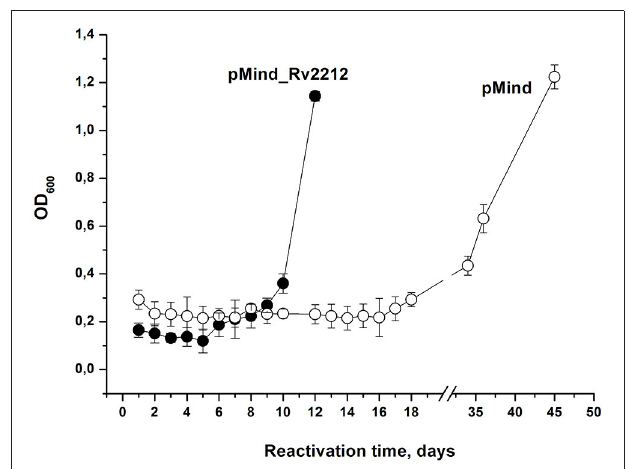
FIGURE 4 | Overexpression of Rv2212 results in faster resuscitation of dormant M. tuberculosis . Non-culturable Mtb pMind Rv2212 (closed circles) or pMind (open circles) obtained from the “glycerol” Sauton’s modified medium after 180-d incubation (see the legend to Figure 2A ) were washed, inoculated in the reactivation medium and incubated with agitation (100 rpm) at 37 ◦ C. For the details see Materials and Methods. The experiment was repeated two times with similar